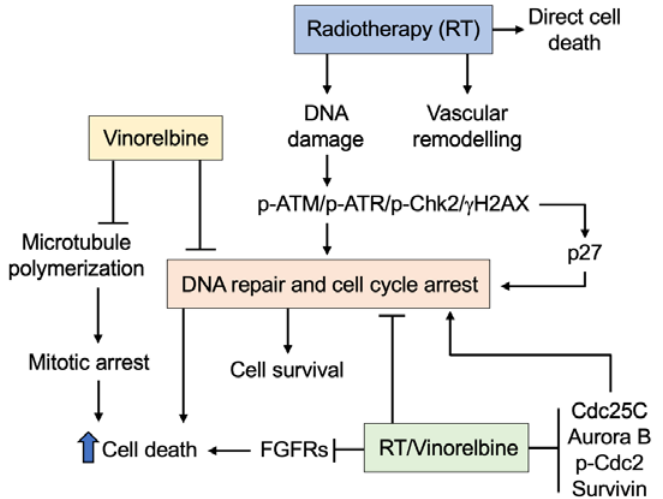
Figure 5. Proposed mechanism for Vinorelbine’s radio sensitizing e ff ect. Radiotherapy induces DNA damage that activates the p-ATM / p-ATR / p-Chk2 / γ H2AX pathway, which in turn activates the cell cycle control protein, leading to G2 / M cell cycle arrest and DNA repair. Under normal circumstances where DNA is repaired, cells continue to proliferate. However, failure to repair damaged DNA leads to cell death. Radiotherapy also induces vascular remodeling by increasing vascular density, which may facilitate the delivery of Vinorelbine. Vinorelbine alone inhibited microtubule polymerization, leading to mitotic arrest and cell death. Furthermore, Vinorelbine inhibited the p-ATM / p-ATR / p-Chk2 pathway, thus reducing cellular DNA repair, which results in increased cell death. Increased levels of DNA damage, the inability to repair DNA, inhibition of FGFR expression, and prolonged mitotic arrest due to inhibition of Cdc25C, Aurora B, survivin, and p-Cdc2 by the combination of RT / Vinorelbine led to more cell death, indicated by elevated levels of cleaved caspase